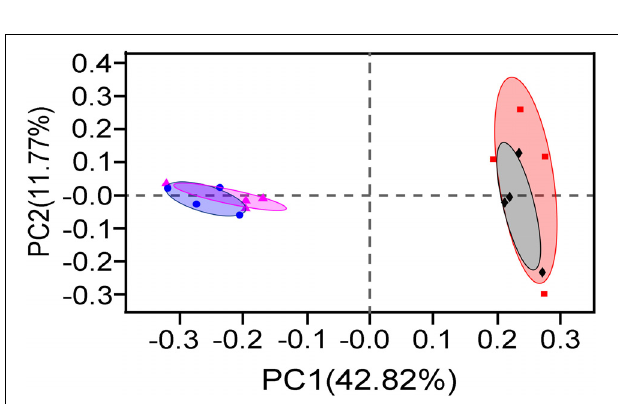
FIGURE 3 | Shannon index based on OTUs in different PM samples. The 5-year PM and 20-year PM were treated with PMA to identify viable bacteria (5-year Viable, 20-year Viable), whereas they were not treated with PMA to identify total bacteria (5-year Total, 20-year Total). The non-parametric rank sum test was used to compare two groups of Shannon index.